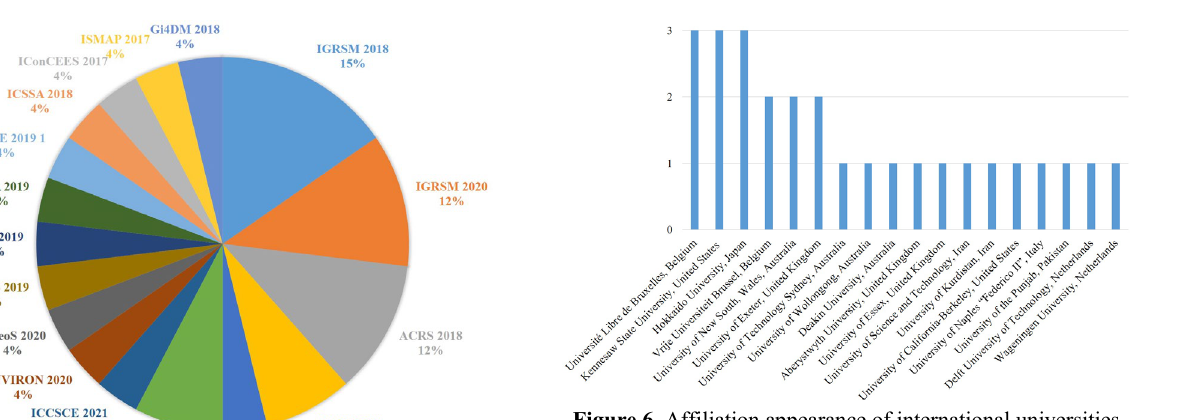
Figure 6. Affiliation appearance of international universities.